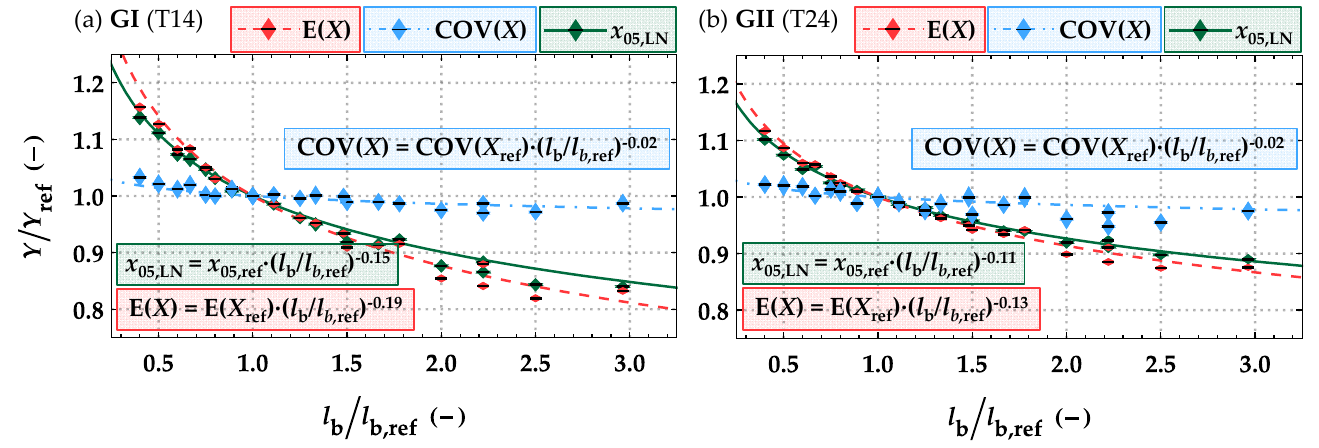
Figure 12. Influence of the length on the main statistics Y = {E( X ); COV( X ); x 05,LN } of the tensile strength parallel to the grain of boards ( X = f t,0,b ) relative to the statistics at a reference length l b,ref = 9 × w b ; analysis based on virtually generated boards for GI ( a ) and GII ( b ).